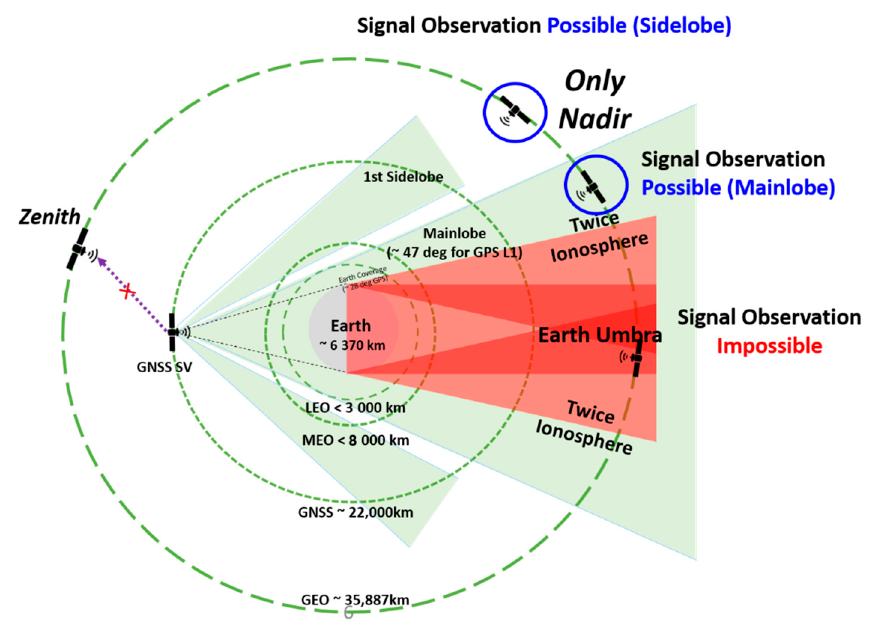
Figure 1. The geometry of GNSS signals in Space Service Volume (SSV).